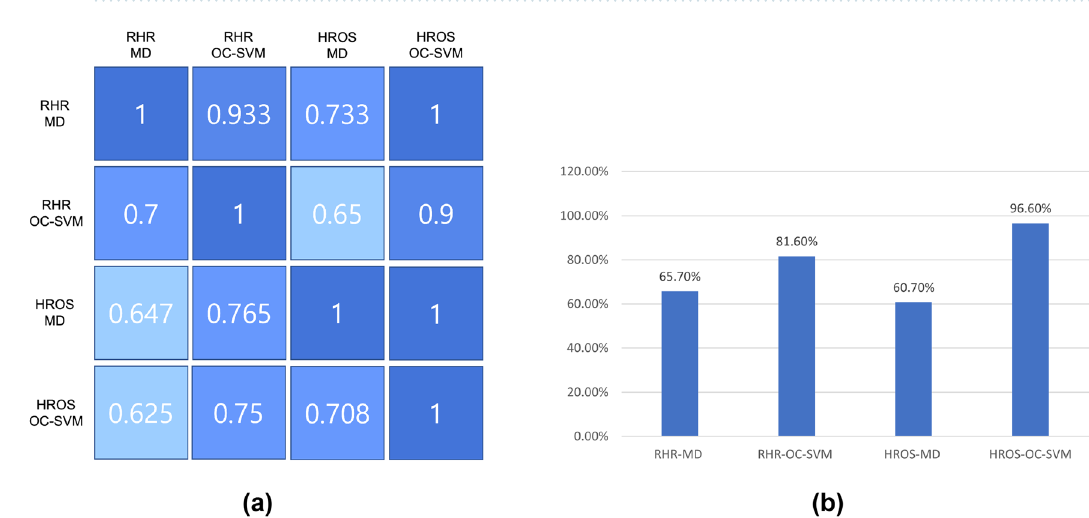
Figure 1. ( a ) A confusion matrix of the relative accuracy rates of the anomaly detection techniques. ( b ) The average the relative accuracy rate of each technique w.r.t the other techniques.